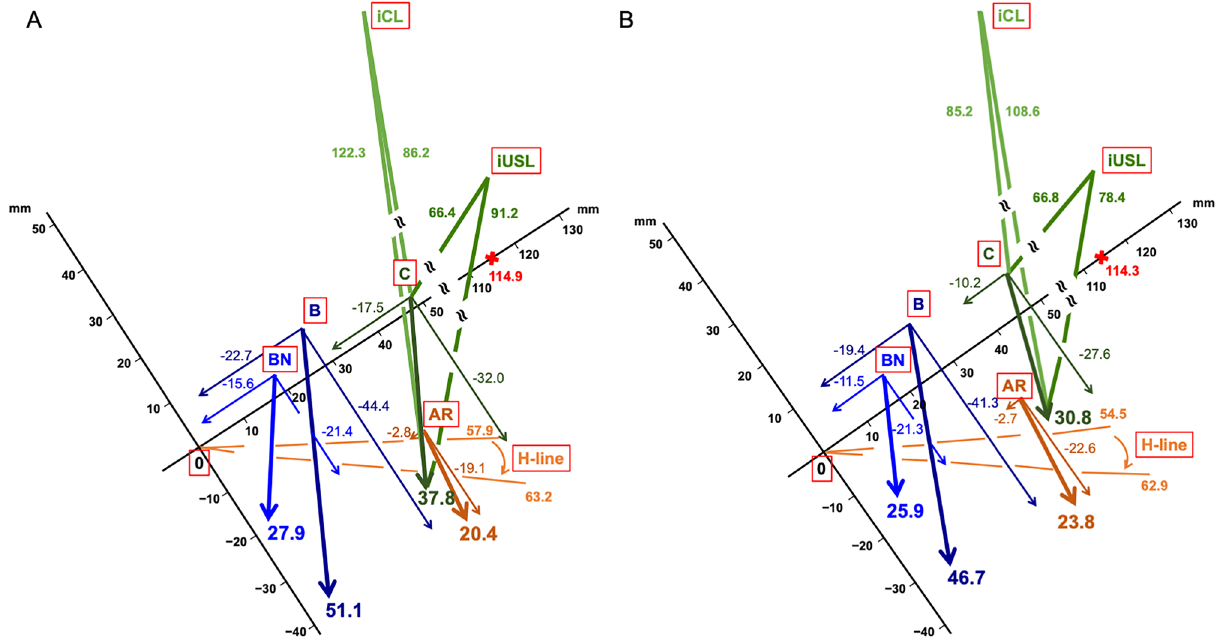
Figure 1. Graphic presentation of coordinate positions of pelvic organs at rest and during straining as well as mean values (mm) of pelvic organ mobilities during straining in patients with overactive bladder (OAB) ( A ) and without OAB ( B ). The sacrococcygeal inferior pubic point line (X-axis) and Y-axis are tilted counterclockwise based on the mean angle in relation to the bottom line on dynamic MRI images; non-OAB, 35.7° [95% confidence interval (CI) 31.3°, 37.0°]; OAB, 33.7° (95% CI 31.3°, 36.1°). To avoid further cluttering this figure, the hiatal descent and anterior vaginal wall length were not drawn on the figure. 0, inferior margin of the symphysis pubis; AR, anorectal angle; B, most dependent position of the bladder; BN, bladder neck; C, uterine cervix; H-line, length of the urogenital hiatus; iCL, imaginary line of the cardinal ligament; iUSL, imaginary line of the uterosacral ligament; X, sacrococcygeal